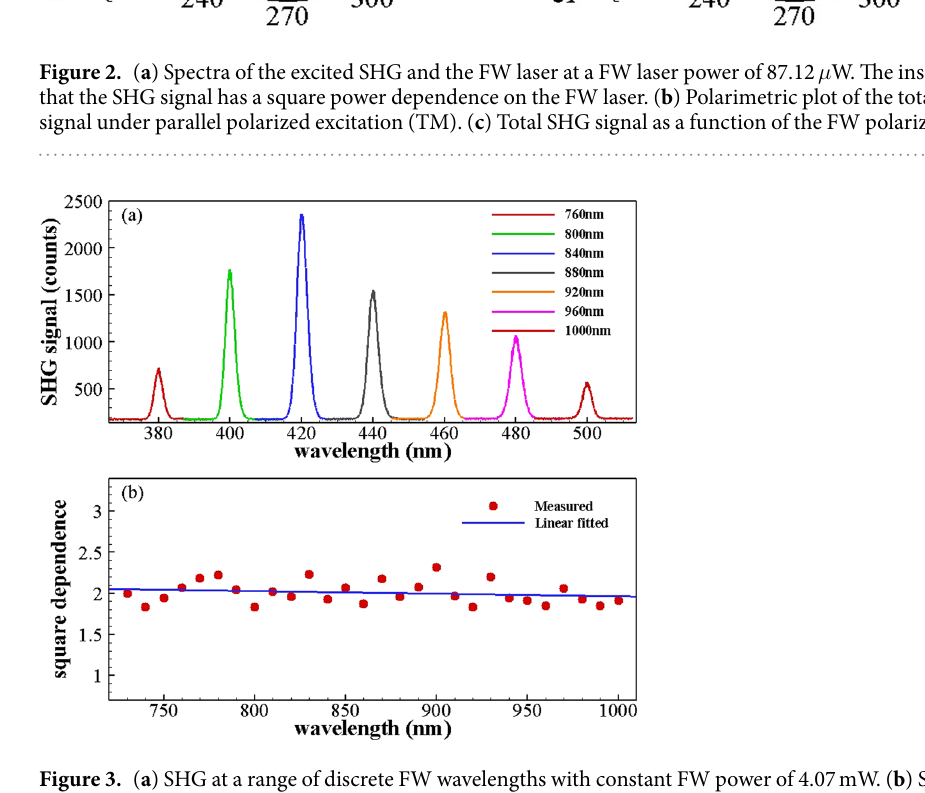
fs laser over a broad wavelength range. As shown in Fig. 3(b), the SHG signal has a quadratic power dependence on the FW laser over the FW wavelength range, which indicates that this is a second-order nonlinear process. Most importantly, this broadband SHG process demonstrates wavelength insensitivity, which can be attributed